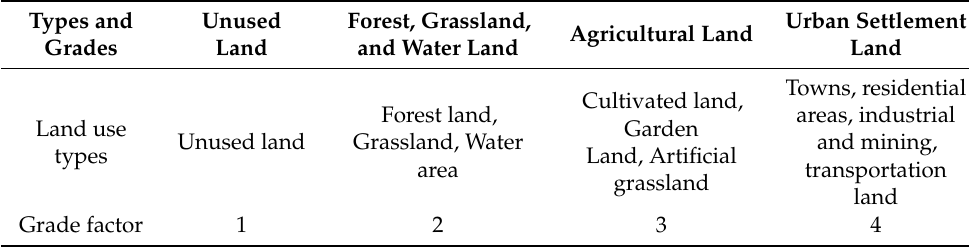
Table 1. Graded assignments of land use